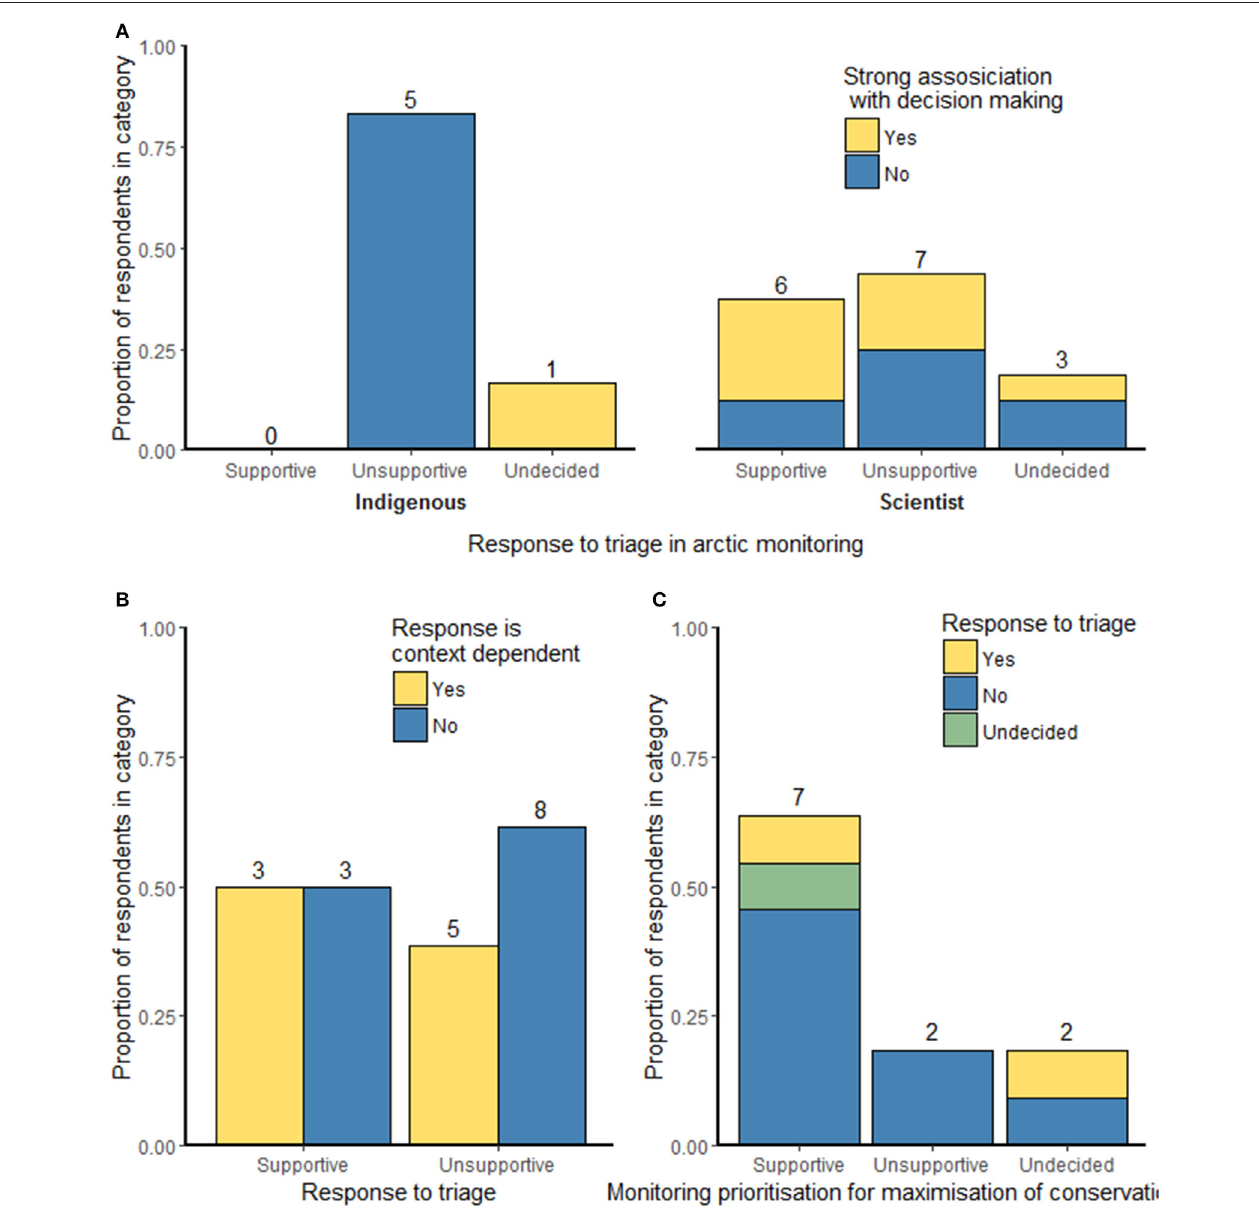
FIGURE 1 | Summary of stakeholder responses to triage and related issues (A) shows differences between representatives of Indigenous groups, scientists and individuals strongly related to decision-making in responses to triage, (B) shows the whether respondents supportive and unsupportive to triage showed a degree of context dependence in whether application of triage might be justified, (C) shows the responses of a subset of individuals asked whether monitoring should be prioritized for maximization of benefit for conservation and whether individuals were supportive of triage. Numbers of participants responding in a given way are indicated above